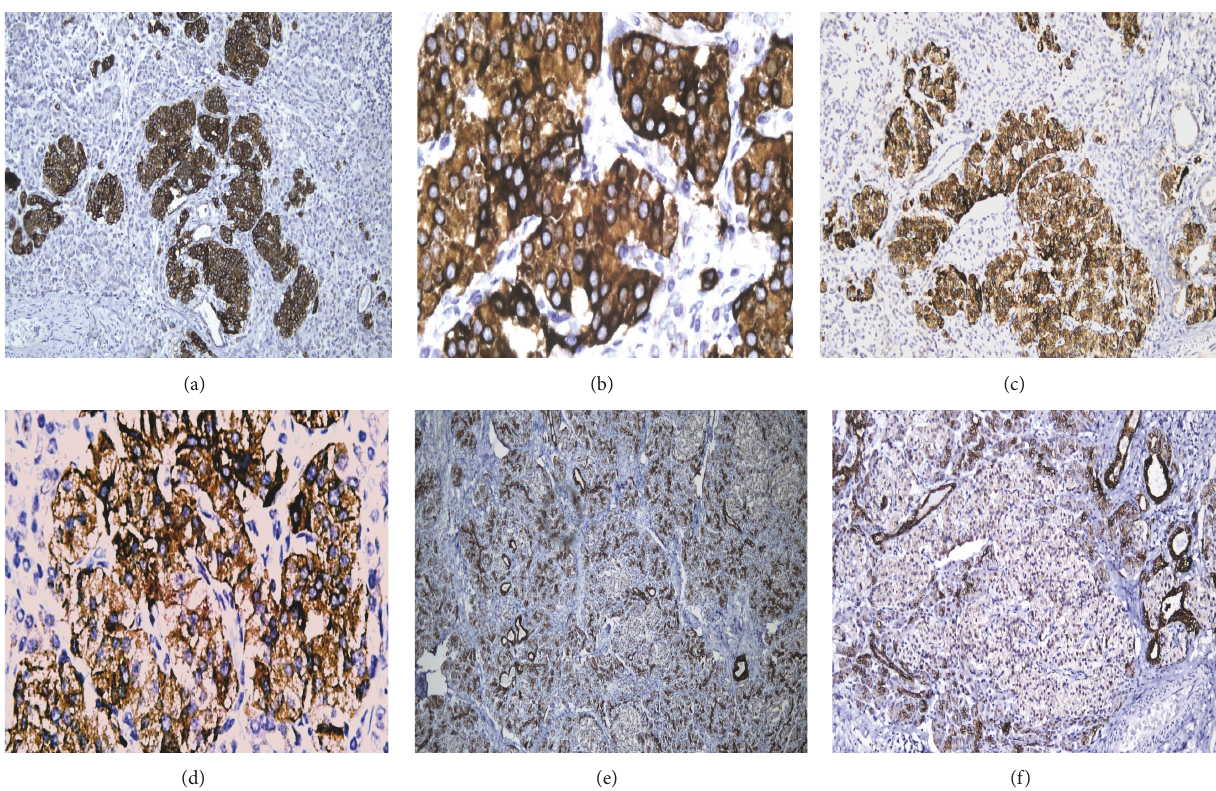
Figure 3: Immunohistochemical staining. (a and b) High expression of insulin in pancreatic beta cells of islets of Langerhans (10x–40x). (c and d) Strong positivity of chromogranin in islets of Langerhans (10x–40x). (e and f) Cytokeratin showed strong positivity in acinic cells and pancreatic duct; meanwhile endocrine cells showed very weak expression